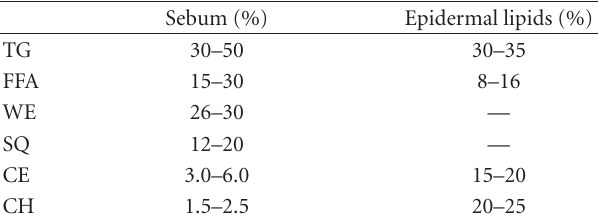
Table 1: Components of skin surface lipids . Triglycerides (TG); Free fatty acids (FFA); Wax esters (WE); Squalene (SQ); Cholesterol Esters (CE); Cholesterol